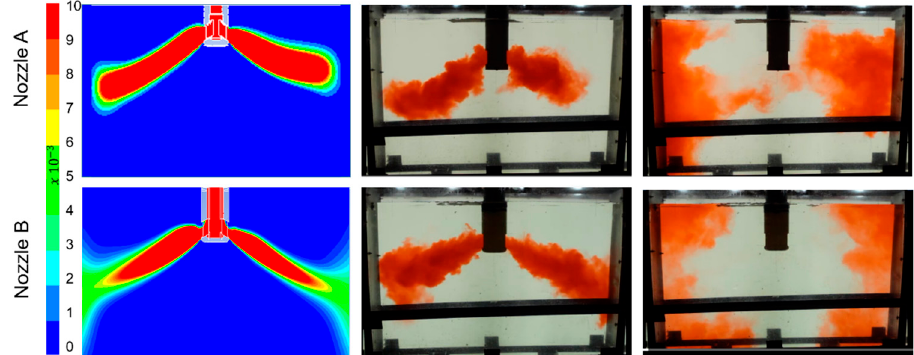
Figure 13. (Color) Comparison between the flow behavior through tracer injection, at the instant of 4 s for the mathematical and physical models.